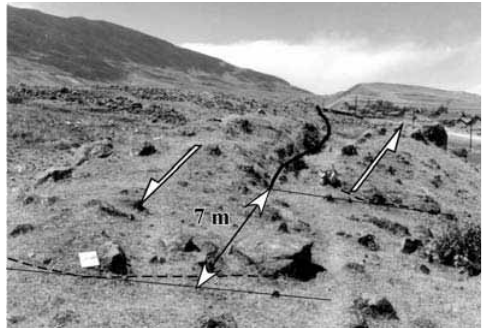
Fig. 3. Near the Sijiabushi village a 50 cm wide fis- sure due to the A.D. 1850 earthquake offset sini- strally a small pressure ridge by 7 m, view to